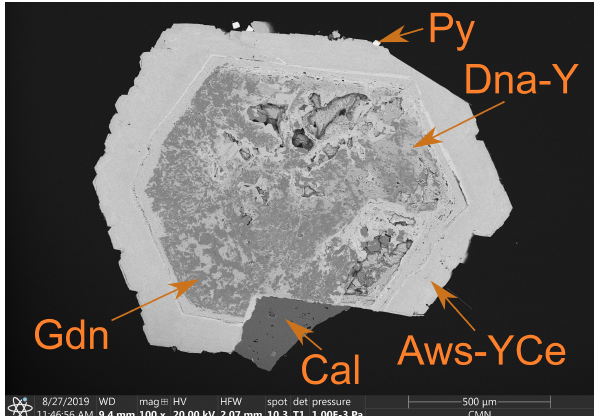
Figure 2. Donnayite-(Y) partially replaced by gaidonnayite with a rim of alicewilsonite-(YCe). Aws-YCe – alicewilsonite-(YCe), Dna-Y – donnayite-(Y), Gdn – gaidonnayite, Cal – calcite, Py – pyrite. Polished section. SEM (BSE) image. Specimen CMNMC 53660 (the